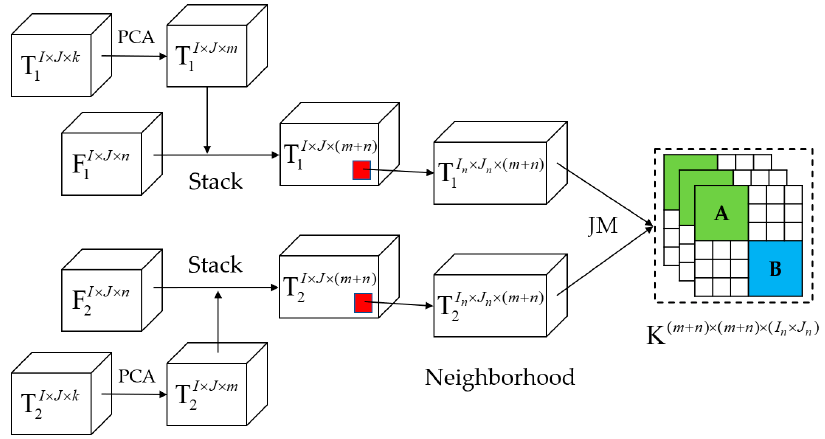
Figure 3. The flow chart of the information fusion.